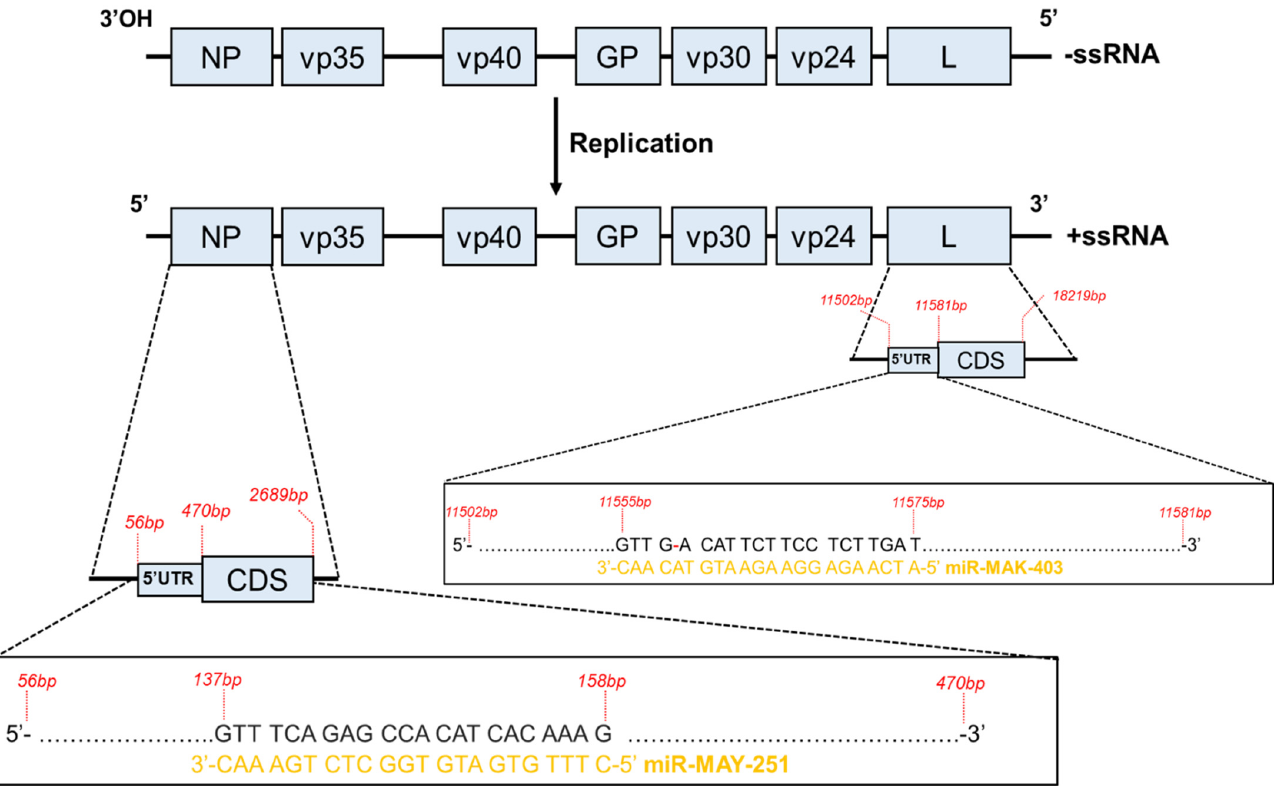
Figure 2. Schematic representation of the EBOV genome, transcribed mRNAs and two potential microRNAs. The two EBOV-derived microRNAs, miR-MAY-251 and miR-MAK-403, are located in the 5 ′ untranslated region (5 ′ UTR) of NP (137–158 bp) and L (11555–11575 bp), respectively. Negative ( − )/Positive (+); ssRNA, single-strand RNA; CDS, coding DNA sequence.